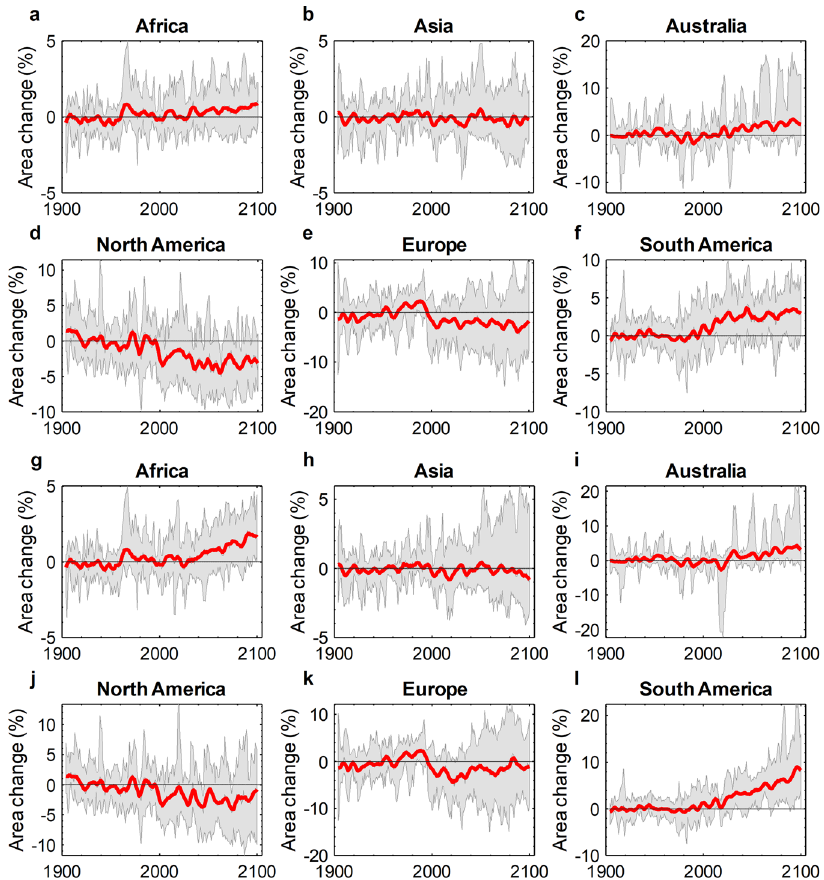
Fig. 3 Continental-level predicted annual change in the total area of soils with an EC e ≥ 2 dS m − 1 relative to the 20th century average (1904 – 1999) for the models obtained from the CMIP6 data project. a – f Relative change under SSP 2-4.5 greenhouse gas concentration trajectory. g – l Relative change under SSP 5-8.5 greenhouse gas concentration trajectory. Shaded areas show the minimum and maximum range of the relative changes predicted by multi- model ensemble members. Red lines show the low-pass fi ltered (5-year running window) of the multi-model ensemble mean of the predicted variations; since all spatio-temporal predictors are fi ve-year moving averages, 1904 is the beginning of the